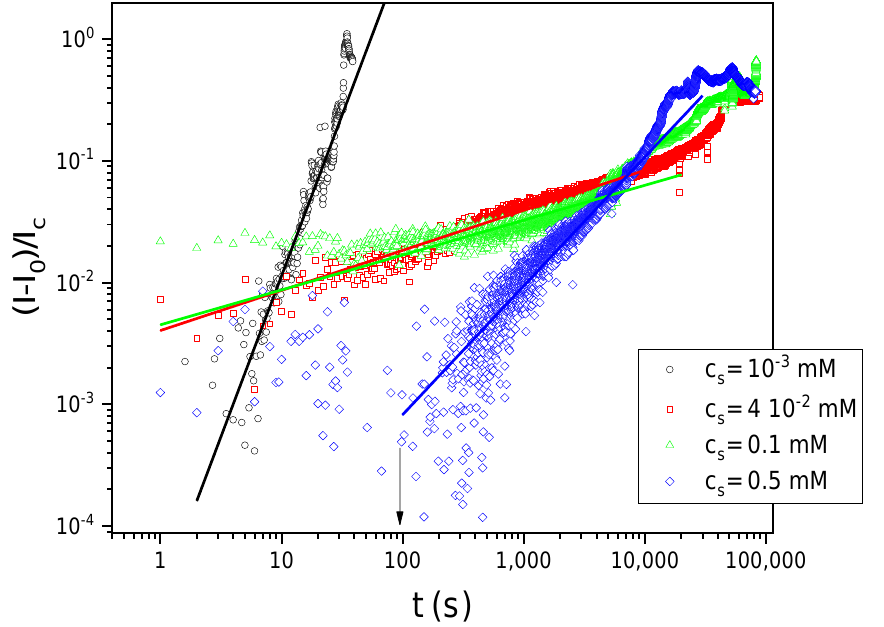
Figure 11. Foam dynamics from multiple light scattering experiments. The abscise represents the relative light intensity transmitted through the foam sample. I is the instantaneous light intensity transmitted through the sample, I 0 the intensity a time zero and I c the transmitted light intensity through the cell without foam (( I–I 0 )/ I c = 1 corresponds to the light transmitted through the container without foam). All measurements were performed at pH 3 and for the four surfactant concentrations studied: 10 − 3 mM ( black circles ); 4 × 10 − 2 mM ( red squares ), 0.1 mM ( green triangles ), and 0.5 mM ( blue diamonds ). The lines are fittings with scaling laws (see Discussion).